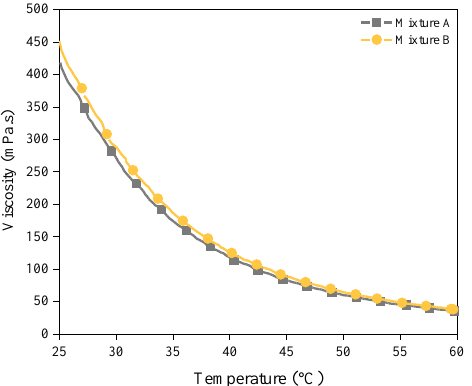
Figure 5. The changes in the viscosities of Mixture A and Mixture B by increasing the temperature from 25 to 60 °C under a constant shear rate of 50 S −1 .